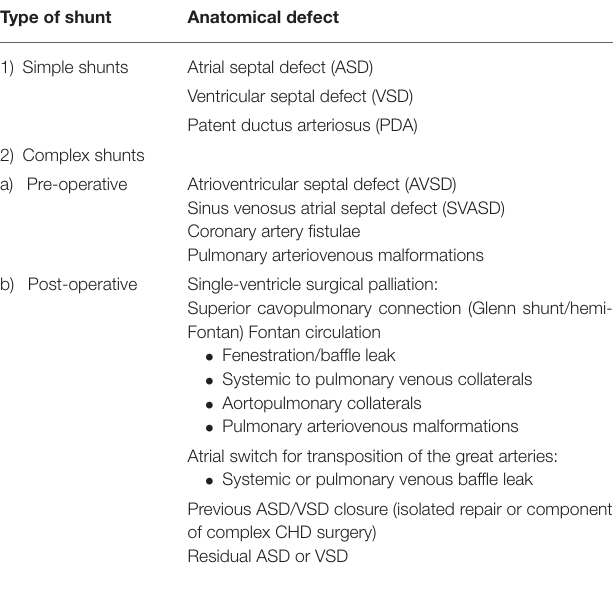
TABLE 1 | Summary of shunt lesions in congenital heart disease. Type of